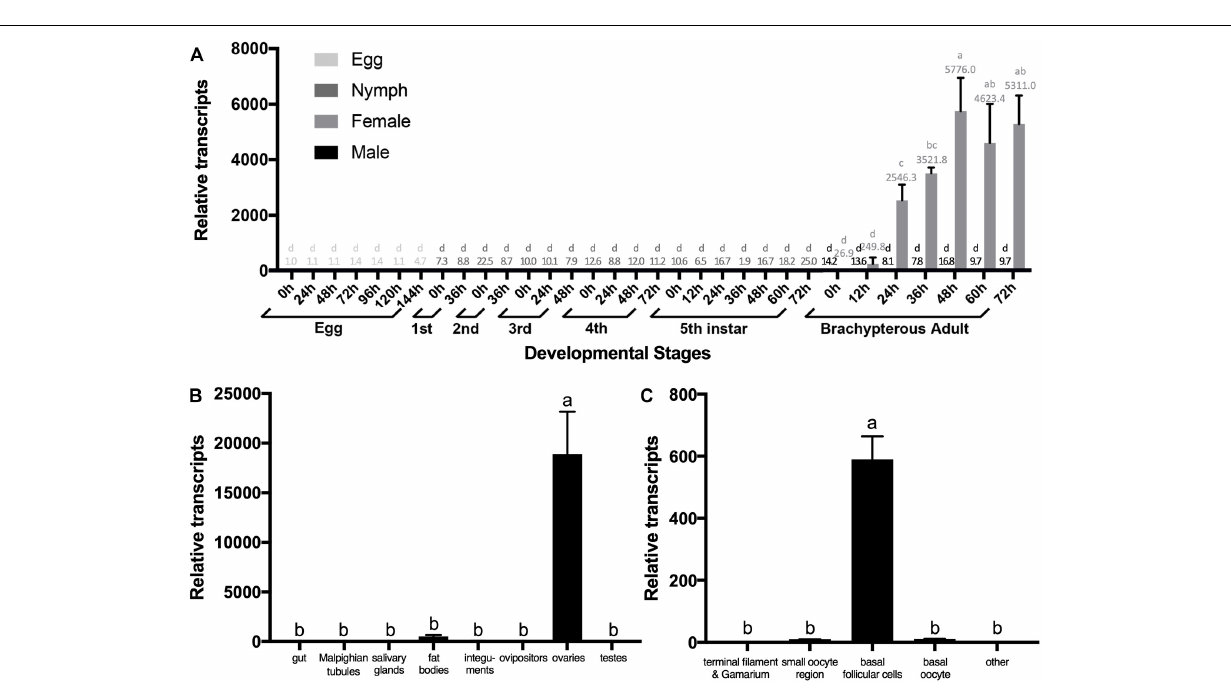
FIGURE 2 | The expression pattern of NlESMuc . (A) NlESMuc expression according to BPH developmental stage. Samples were collected from eggs, nymphs, and brachypterous male and female adults. The NlESMuc mRNA level in eggs at 0 h was designated 1 and relative expression levels for each sample were marked in different colors according to the color code. (B) NlESMuc expression in BPH tissues. The digestive tract ( n = 50), Malpighian tubes ( n = 50), salivary glands ( n = 80), fat bodies ( n = 50), ovipositors ( n = 30) and integument ( n = 20) of brachypterous females were dissected 48–120 h after emergence, while the inner reproductive organs ( n = 30), testes (male), and ovaries (female) of brachypterous adults were dissected 48–120 h after emergence. The NlESMuc mRNA level in the integument was designated 1. (C) NlESMuc expression in BPH ovary. The terminal filament–germarium region, small oocyte region (containing small developing oocytes < 800 µ m and active follicular cells), basal oocytes (oocytes ∼ 850 µ m in length), basal follicular cells (follicular cells around the basal oocytes), and other parts (oviduct, bursa copulatrix, spermatheca, pouched gland) were dissected from brachypterous adult females 48–120 h after emergence. The NlESMuc mRNA level in the other parts was designated 1. Nl18S and RPS11 were used as internal control genes. Data represent the relative NlESMuc mRNA levels. Data are the mean ± SEM from three independent experiments. Columns followed by a common letter are not significantly different by the HSD-test at the 5% level of significance in each